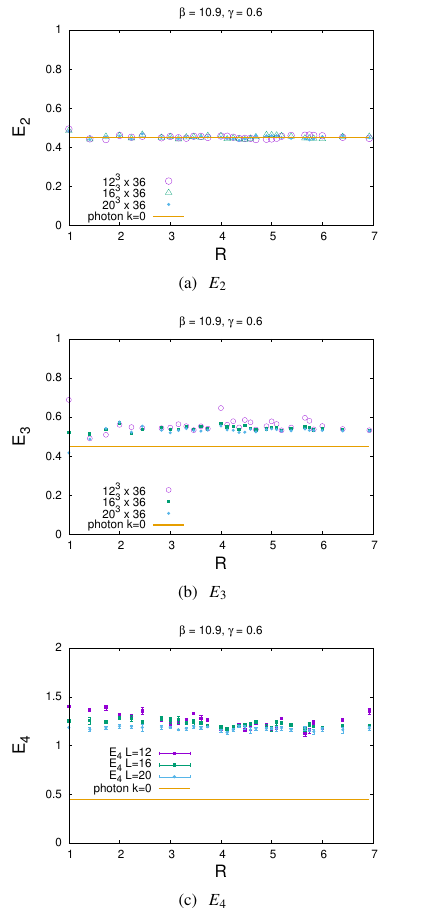
Figure 6. Excitation energies E n ( R ) vs. R for lattice volumes 12 3 , 16 3 , 20 3 × 36. (a) E 2 ( R ); (b) E 3 ( R ), (c) E 4 ( R ). Note that fluctuations with R tend to decrease with higher volumes.